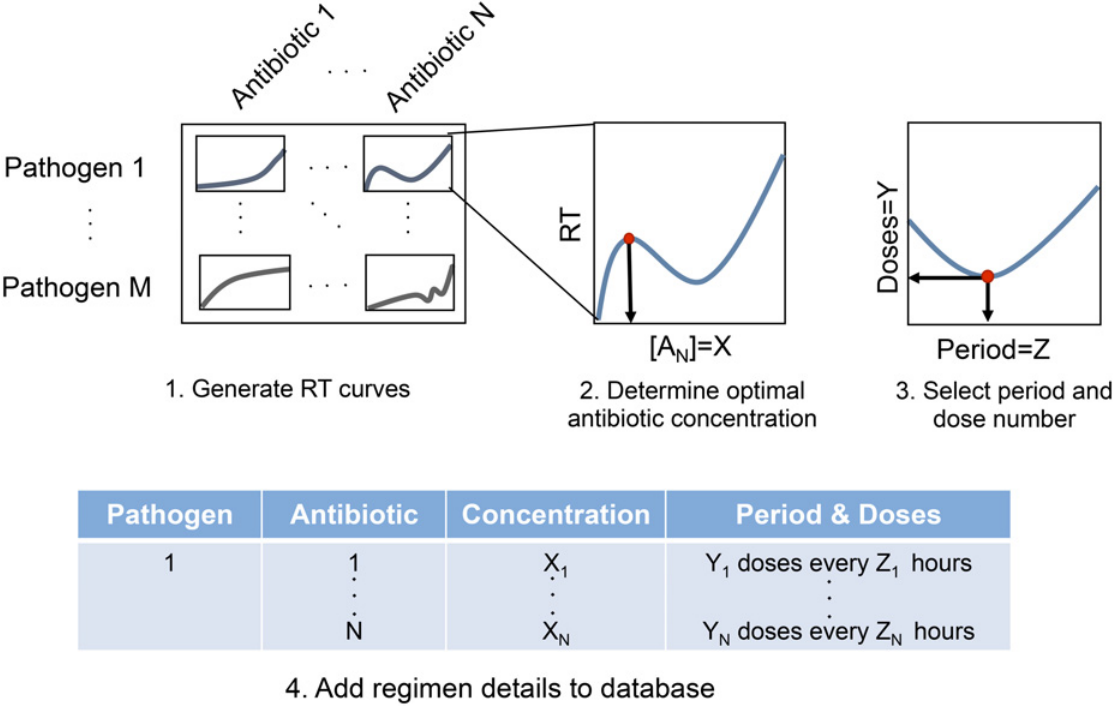
Fig 5. Potential use of recovery time to guide clinical practice. A critical step entails the construction of a comprehensive database of the recovery time curves of various pathogens under different antibiotics. Based on the recovery time curve, the optimal antibiotic concentration (X), dose number (Y), and period length (Z) can be calculated for each pathogen-antibiotic combination and entered into a database. Given this database and a proper diagnosis of a pathogen, one can readily identify the most effective treatment protocol.